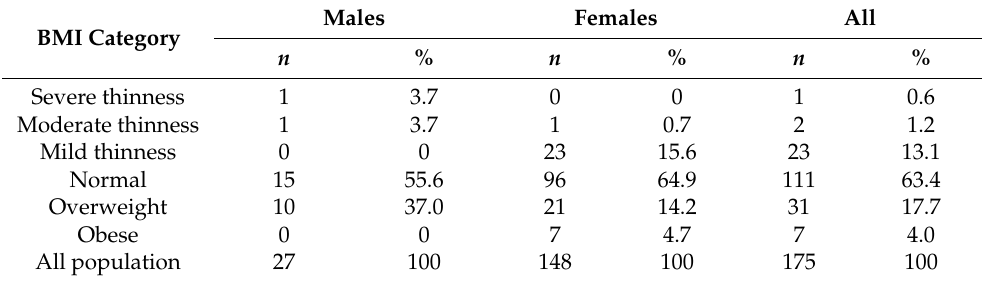
Table 3. Sex differences according to the body mass index (BMI) in studied